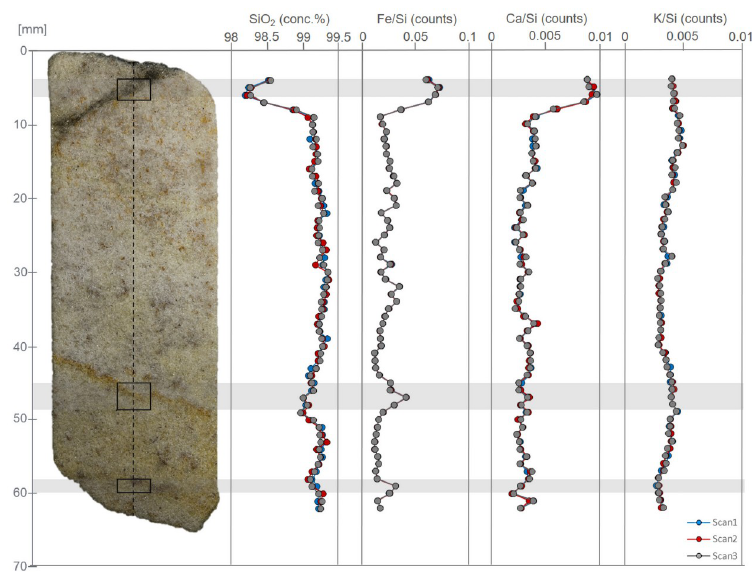
Fig 16. Optical image and selected XRF data for section 2–3 of the Phillips’ Core from Stone 58 at Stonehenge. Dashed line indicates path of XRF detector along the central axis length of the sample. Solid boxes indicate areas of interest (see section 4.2.2.). Replicate XRF scans (3 × ) along the same axis line were performed to ensure consistency of the results. The image and data are reproduced under a CC BY 4.0 license, with permission from the British Geological Survey, original copyright